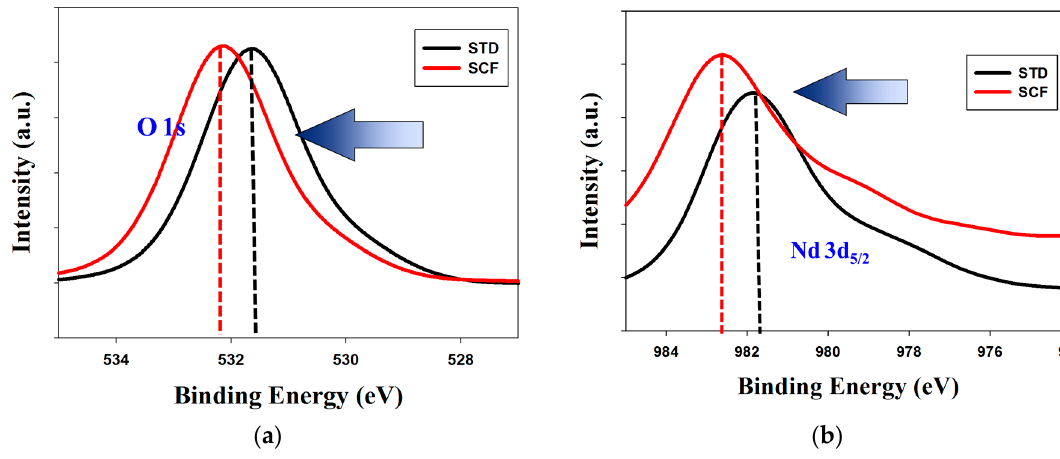
Figure 5. The X-ray photoelectron spectroscopy (XPS) curves of the ( a ) O 1s, and ( b ) Nd 3d 5/2 for SCF-treated and non-treated neodymium oxide thin films.